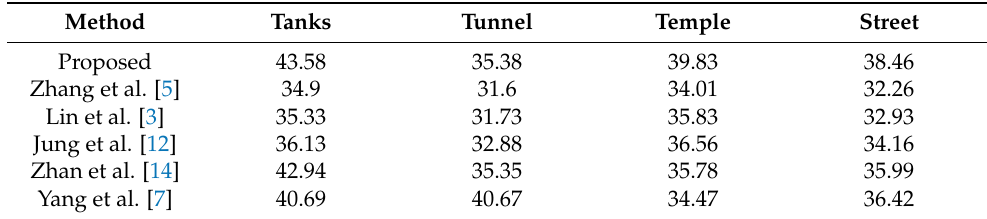
Table 2. Comparative results for average PSNR (dB) values for datasets.